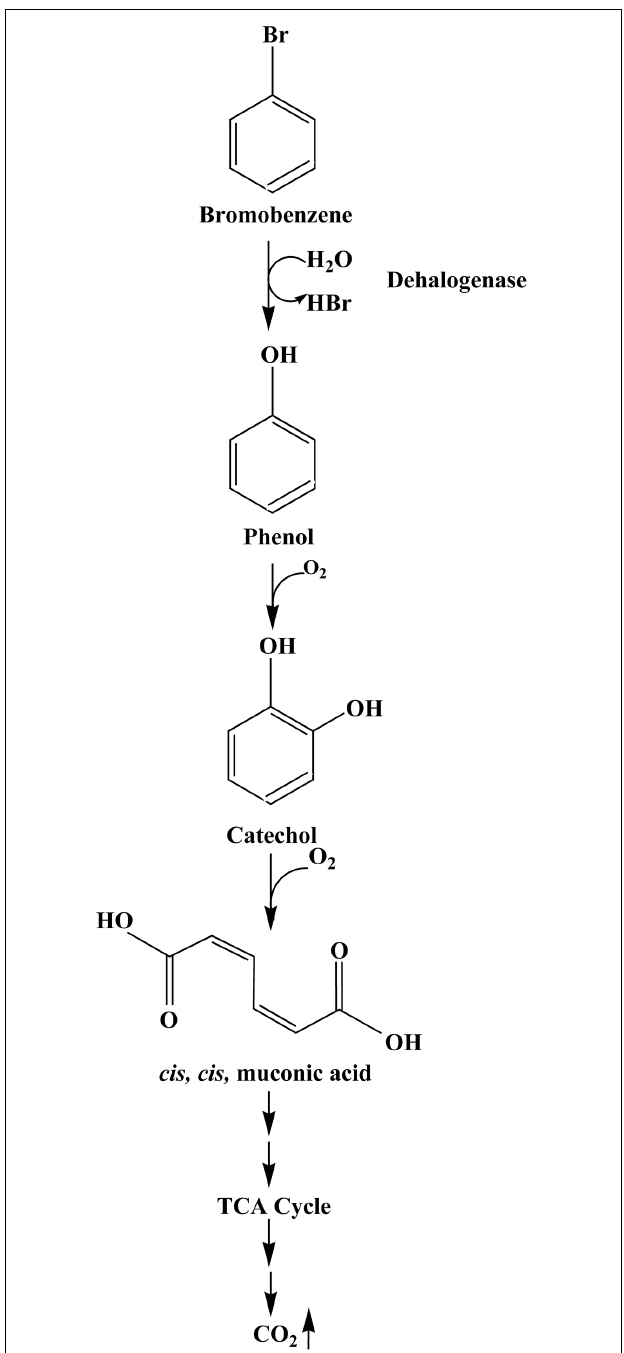
FIGURE 7 | Proposed pathway for BrB degradation by Y. lipolytica NCIM